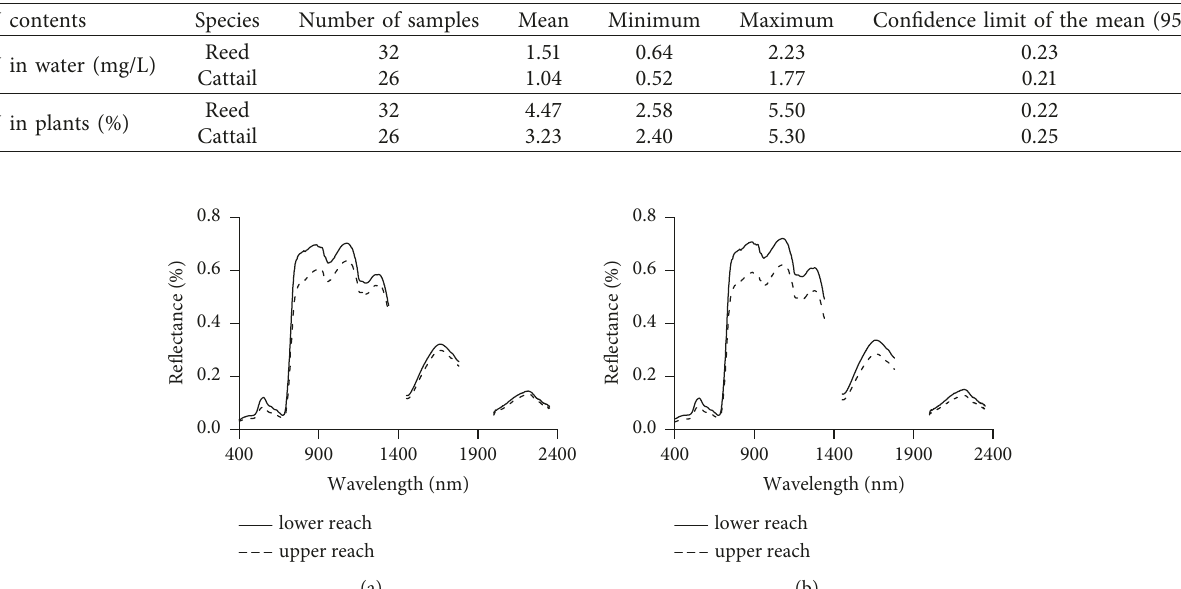
Table 1: TN contents in water and plants.